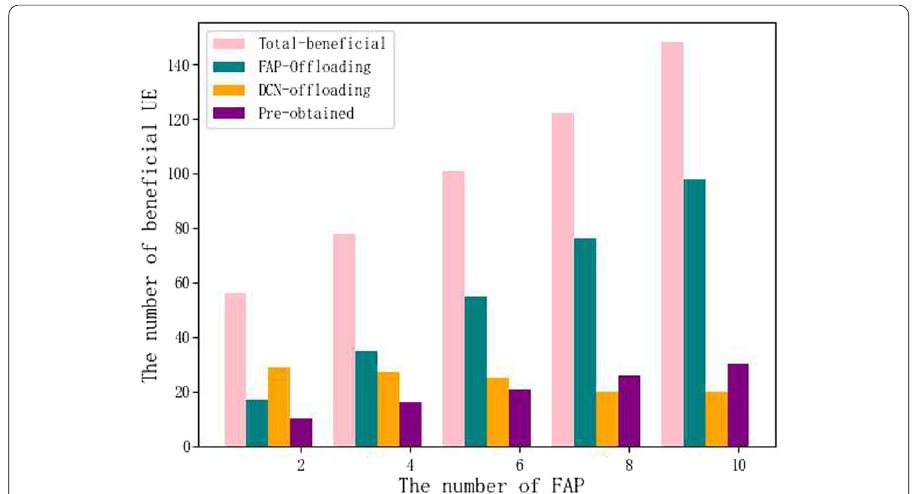
Fig. 9 The total utility of UEs over the average required computational resource of